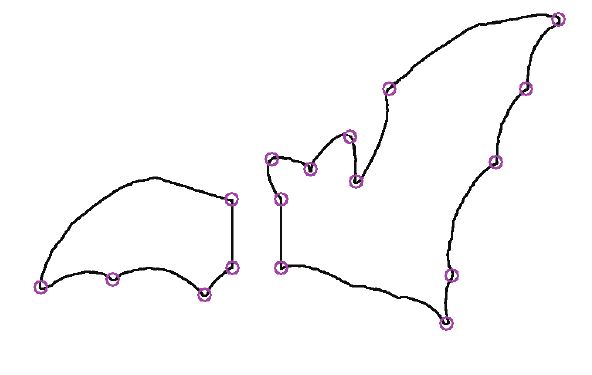
Figure 4. Incomplete contour